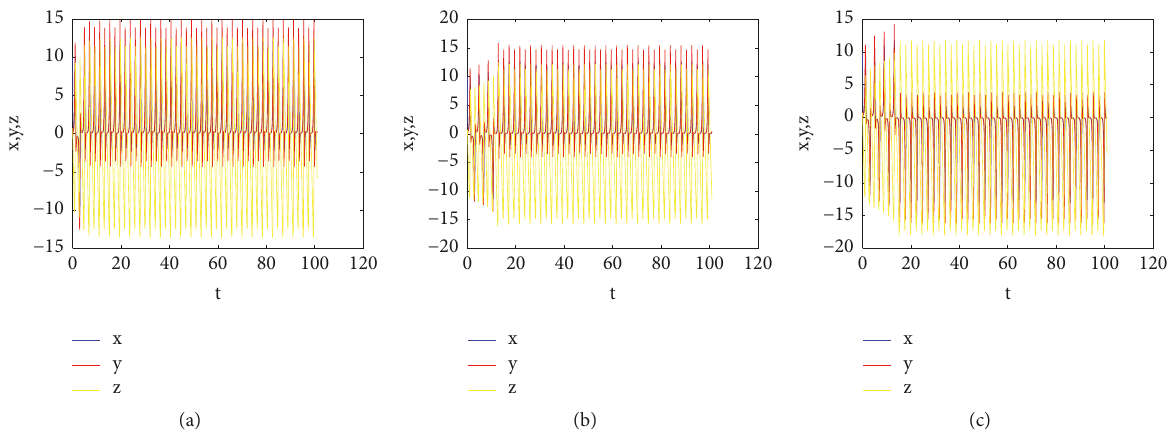
Figure 10: Phase portraits of the 3D chaotic Lorenz type system for Experiment 3 at 𝑐 = 3 : (a) (𝑥,𝑦) -plane; (b) (𝑥,𝑧) -plane; (c) (𝑦,𝑧) -plane.